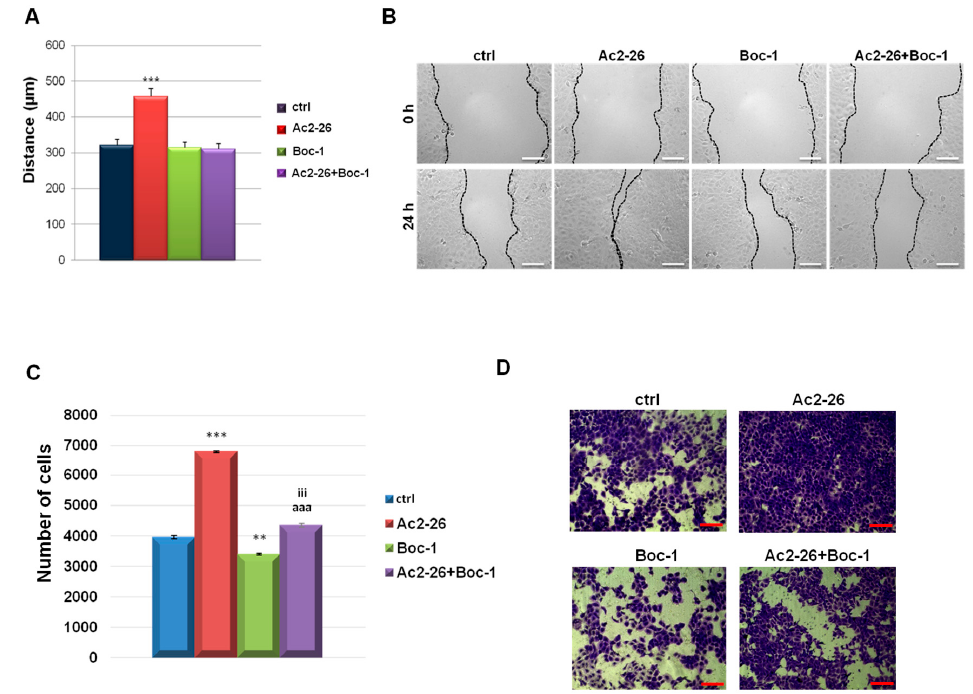
Figure 4. ( A ) Analysis of the migration rate in the presence or not of Ac2-26 (1 µ M) and Boc-1 (100 µ M). The migration rate was determined by measuring the wound closure by individual cells from the initial time (0 h) to the selected time-points (24 h) (bar of distance tool, Leica ASF software). Representative images for migration assay are reported in ( B ). Bar = 150 µ m. ( C ) Analysis of invasion speed of keratinocytes treated or not with Ac2-26 (1 µ M) and Boc-1 (100 µ M). Data represent the mean cell counts of 10 separate fields per well. The data represent a mean of three independent experiments ± SEM, their statistical significance were evaluated using Student’s t -test, assuming a 2-tailed distribution and unequal variance. ** p < 0.01; *** p < 0.001 for treated vs. non treated cells; aaa p < 0.001 for Ac2-26 + Boc-1 vs. Ac2-26; iii p < 0.001 for Ac2-26 + Boc-1 vs. Boc-1. ( D ) Representative images of analysed fields of invasion assay on keratinocytes. Magnification 20 × . Bar = 50 µm.